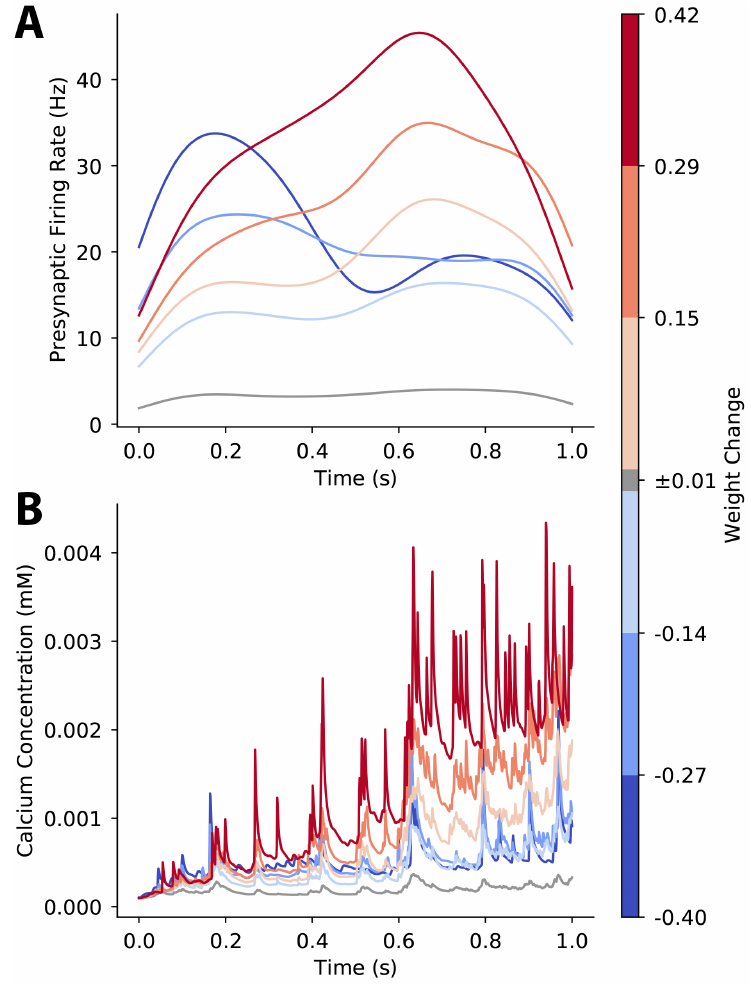
Figure A3. Weight change triggered average pre-synaptic firing rate and calcium concentration. Variability is introduced by moving spikes between trains, to maintain the same instantaneous firing rate overall to the neuron. ( A ) Synapses that potentiate experience a late peak firing rate. ( B ) Mean weight change correlates with calcium amplitude during the second half of the trial for potentiation, whereas mean weight change correlates with calcium amplitude during the first half of the trial for